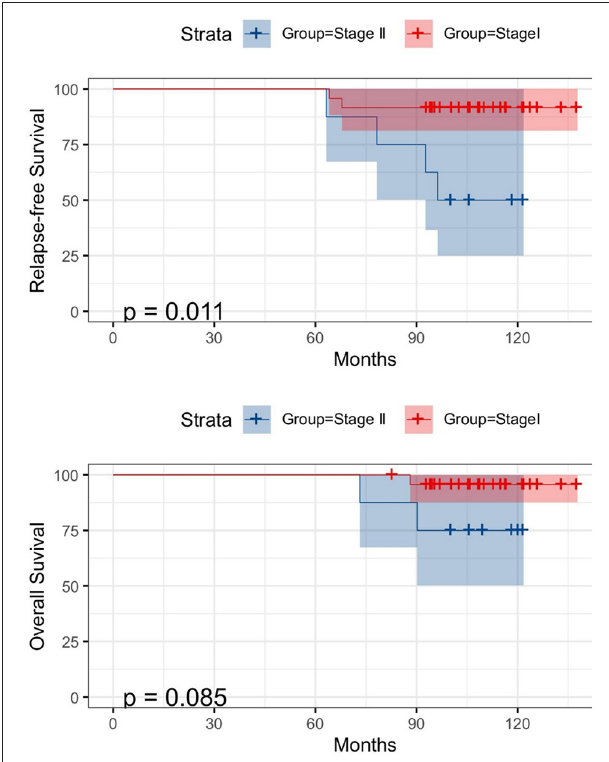
FIGURE 4 | Kaplan-Meier survival curves for RFS (above) and OS (below) according to tumor stage.